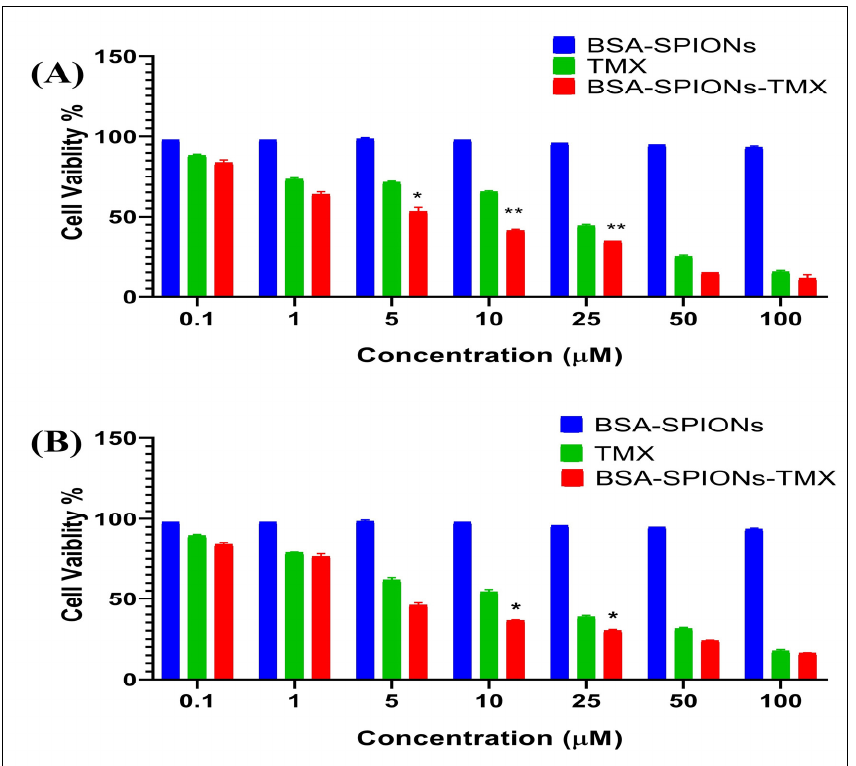
Figure 9. Percentage cell viability profile of TMX and BSA-SPIONs-TMX against ( A ) MCF-7 cell lines and ( B ) T47D cell lines (mean ± SD, n = 3); Note: (* indicates p < 0.05 compared with TMX and ** indicates p < 0.01) compared with BSA-SPIONs-TMX.